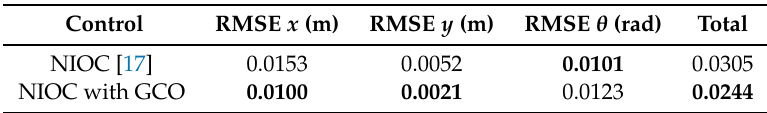
Table 6. Root Mean Squared Error (RMSE) in states for Real-Time experimental test 2. Bold values highlight the best